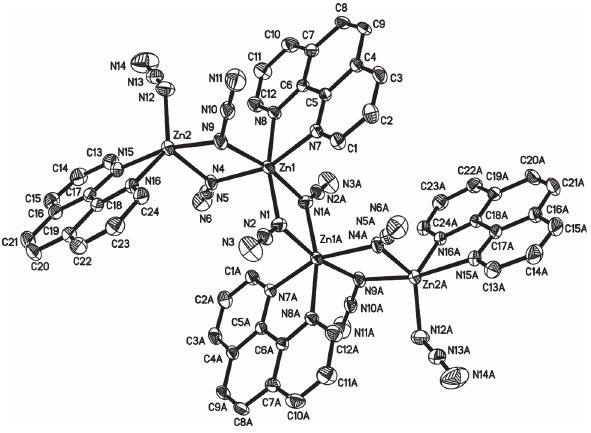
Table 1 contains crystallographic data and Table 2 contains the list of the atoms including atomic coordinates and dis- placement parameters.